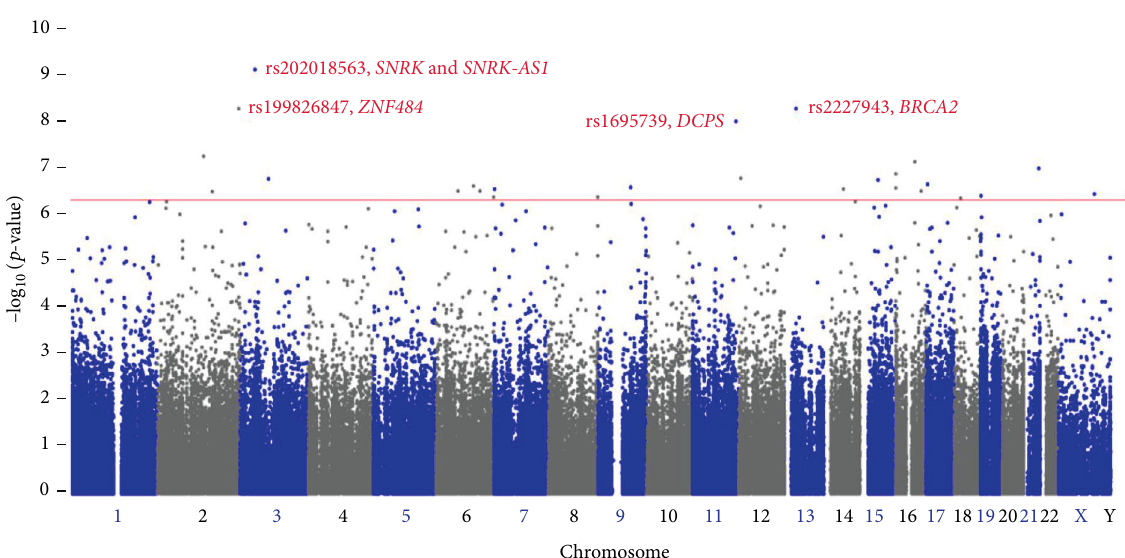
Figure 1: Manhattan plot of exonic 243,345 variants from association study with breast cancer in Saudi Arabians. Association is plotted according to position of the variant on each chromosome with − log 10 ( p values). The horizontal red line indicates the suggestive threshold. Colored SNP in red color denotes the most signi fi cant SNP with p ≤ 9 : 14 × 10 − 09